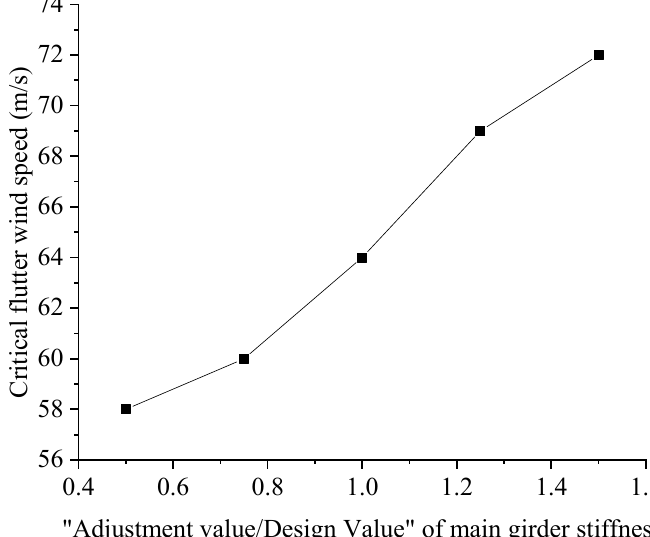
Figure 13. Change curve of flutter critical wind speed with stiffness of main beam. As can be seen from Figure 13, the critical flutter wind speed of Xiangshan Harbor Bridge presented an S-shaped change when the stiffness of the main beam was between 0.5 times and 1.5 times design value. With the increase of the stiffness of the main beam, the critical flutter wind speed increased from 58 m/s when the stiffness of the main beam was 0.5 times to 72 m/s when the stiffness of the main beam was 1.5 times, which is 24.14% higher than that of when the stiffness of the main beam is 0.5 times. The main reason for this phenomenon is that the increase of the stiffness of the main beam improves the torsion frequency of the bridge, which has a positive correlation with the flutter critical wind speed. In general, the change of main beam stiffness is directly proportional to the flutter critical wind speed of Xiangshan Harbor